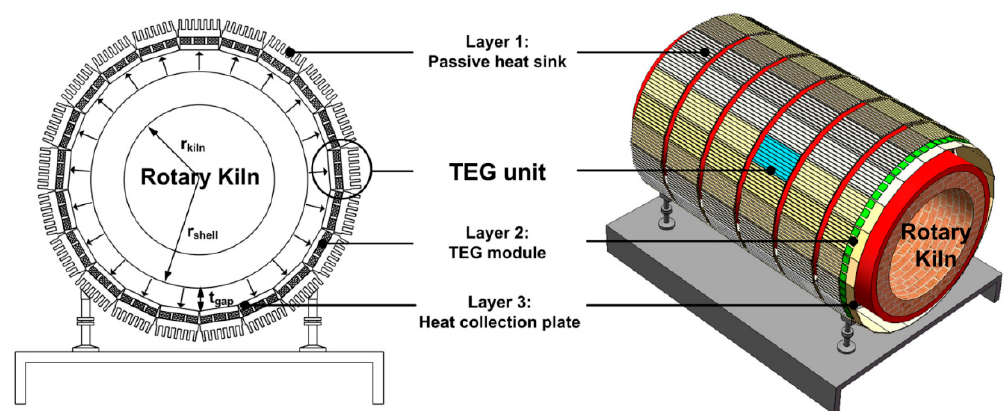
Figure 13. Configuration of a thermoelectric waste heat recycling system for a Portland cement rotary kiln, length: 72 m, diameter: 4.8 m, (adapted from [93]).